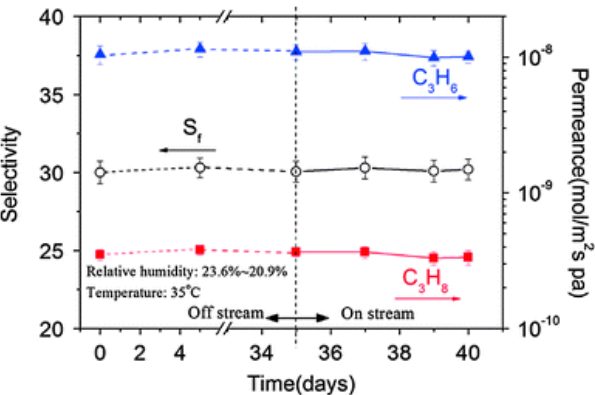
Figure 65. Off-stream stability and on stream stability test of C 3 H 6 –C 3 H 8 mixture gas permeances on the ZIF-8 membrane at 35 °C (adapted with permission from ref. [164]).